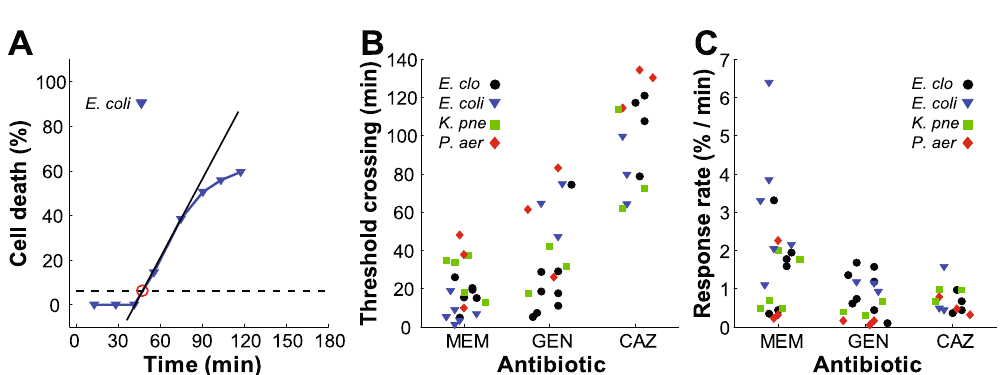
Figure 5. Response dynamics of susceptible strains to the antibiotics tested. ( A) Cell death percentage of E. coli 4674 against GEN. Threshold crossing time (red circle). Linear fit to the rise of the signal (black line). ( B) Threshold crossing times for each antibiotic. All data are randomly distributed for the same antibiotic. All experimental data are shown. ( C ) Response rates vs antibiotic for all susceptible strain